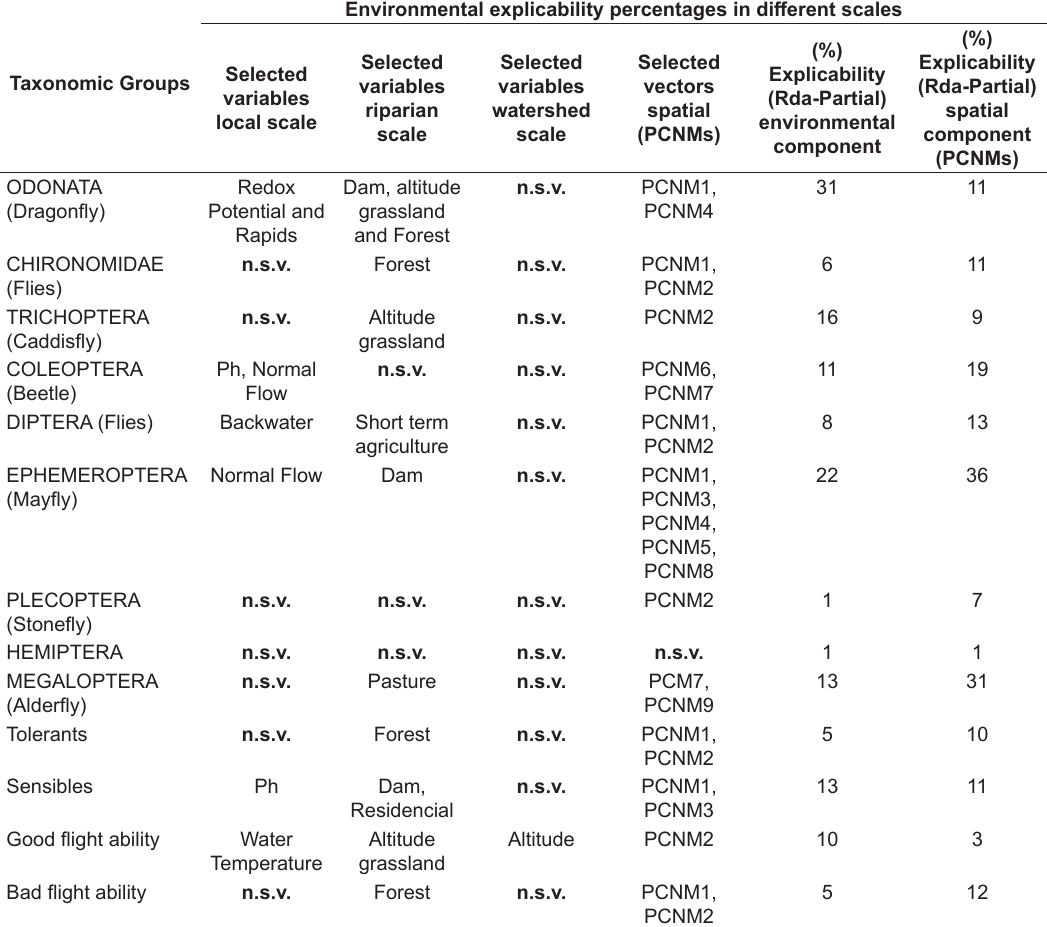
Figure 3. Proportional importance of the spatial and environmental components in the metacommunities grouped in taxonomic groups and deconstructed by biological traits. Proportions are relating Adj R 2 values from redundancy analysis using environmental and spatial matrices as explanatory factors. Table 1. Percentages of explanation with significant variables (p <0.001) selected on multiple scales (limnological, riparian and watershed) of influence on the taxonomic groups for Poços de Caldas